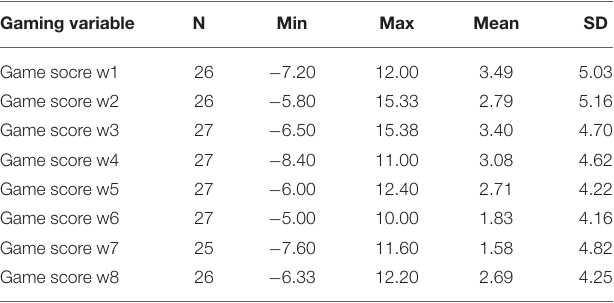
TABLE 3 | Descriptive statistics for the gaming performances based on 8 weeks of gaming data in 27 esport